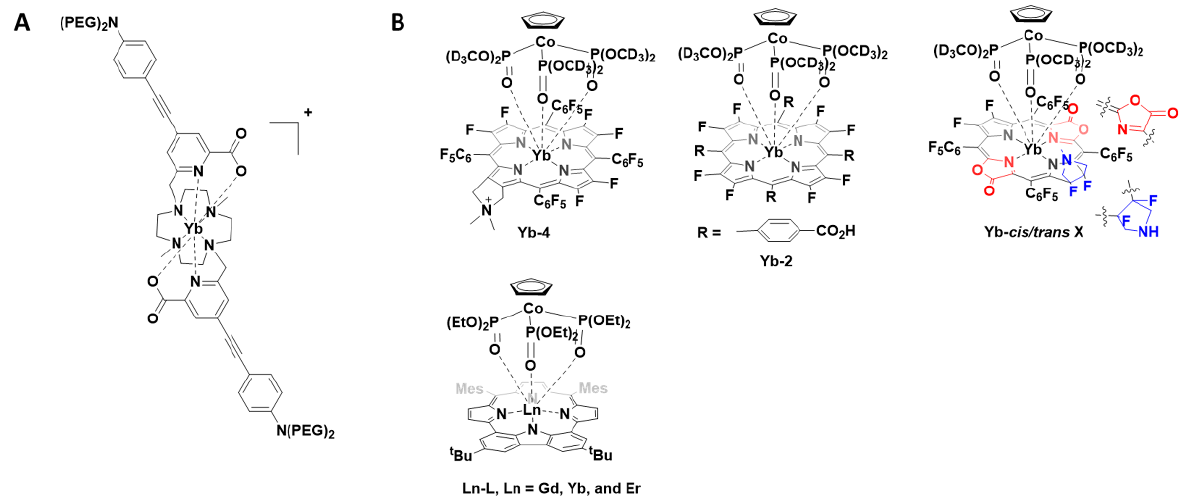
Figure 4. ( A ) Chemical structure of the -coordinate cationic [YbL] + complex; ( B ) Structures of porphyrinates complexes Yb-4, Yb-2, Yb- cis / trans -3 and Ln-L.